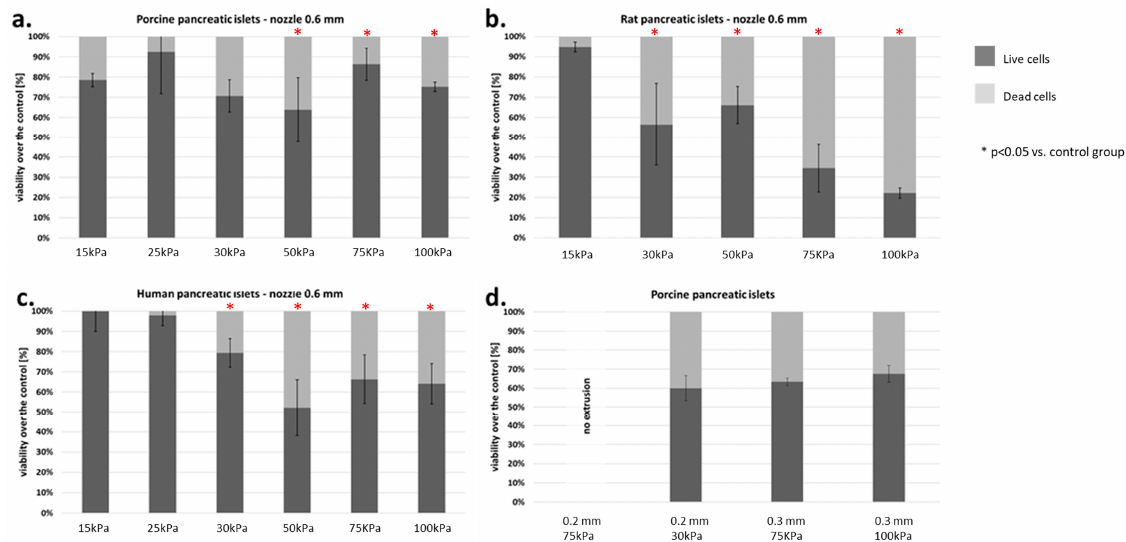
Figure 9. Viability of islets subjected to the bioprinting process with different pressures and a nozzle with an internal diameter of 0.6 mm. As a carrier material, 3% ( w/v ) alginate was used, and the vitality of the islets was assessed based on FDA/PI staining and determined in accordance with Equations (5)–(7). Our control consisted of islets right after the isolation. The P-value for each pressure was calculated in comparison to the control group. ( a ) Porcine pancreatic islets: P -value was determined using Fisher’s method and was 0.22, 0.54, 0.83, 0.042, 0.019, and 0.037 for 15, 25, 30, 50, 75, and 100 kPa groups, respectively. ( b ) Rat pancreatic islets: P -value was 1.0, 0.001, 0.019, 0.002, and 0.0001 for 15, 30, 50, 75, and 100 kPa groups, respectively. ( c ) Human pancreatic islets: P-value was 0.95, 0.47, 0.059, 0.019, 0.034, and 0.048 for 15, 25, 30, 50, 75, and 100 kPa groups, respectively. ( d ) Porcine pancreatic islets: Viability of porcine pancreatic islets subjected to the bioprinting process with different pressures (75 and 200 kPa) and nozzles with an internal diameter 0.2 and 0.3 mm. Statistical significance ( P < 0.05) was observed in each experimental group. N = 3. Analyzing the results obtained on the pancreatic islets, we decided to check how the individual cell lines that make up the pancreatic islets behave. We focused our attention on the two largest populations, i.e., α - and β -cells.